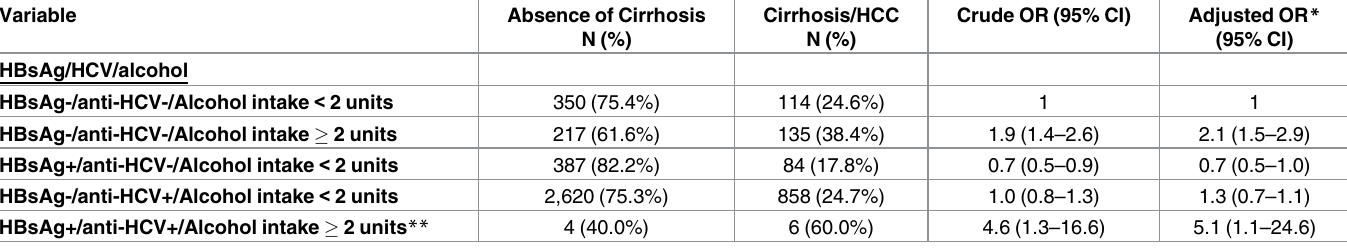
Table 4. Interaction between alcohol intake and co-factors in the progression from chronic hepatitis to cirrhosis in female patients. Crude and AdjustedOdds * Ratio derived from multiplelogistic regressionanalysis.